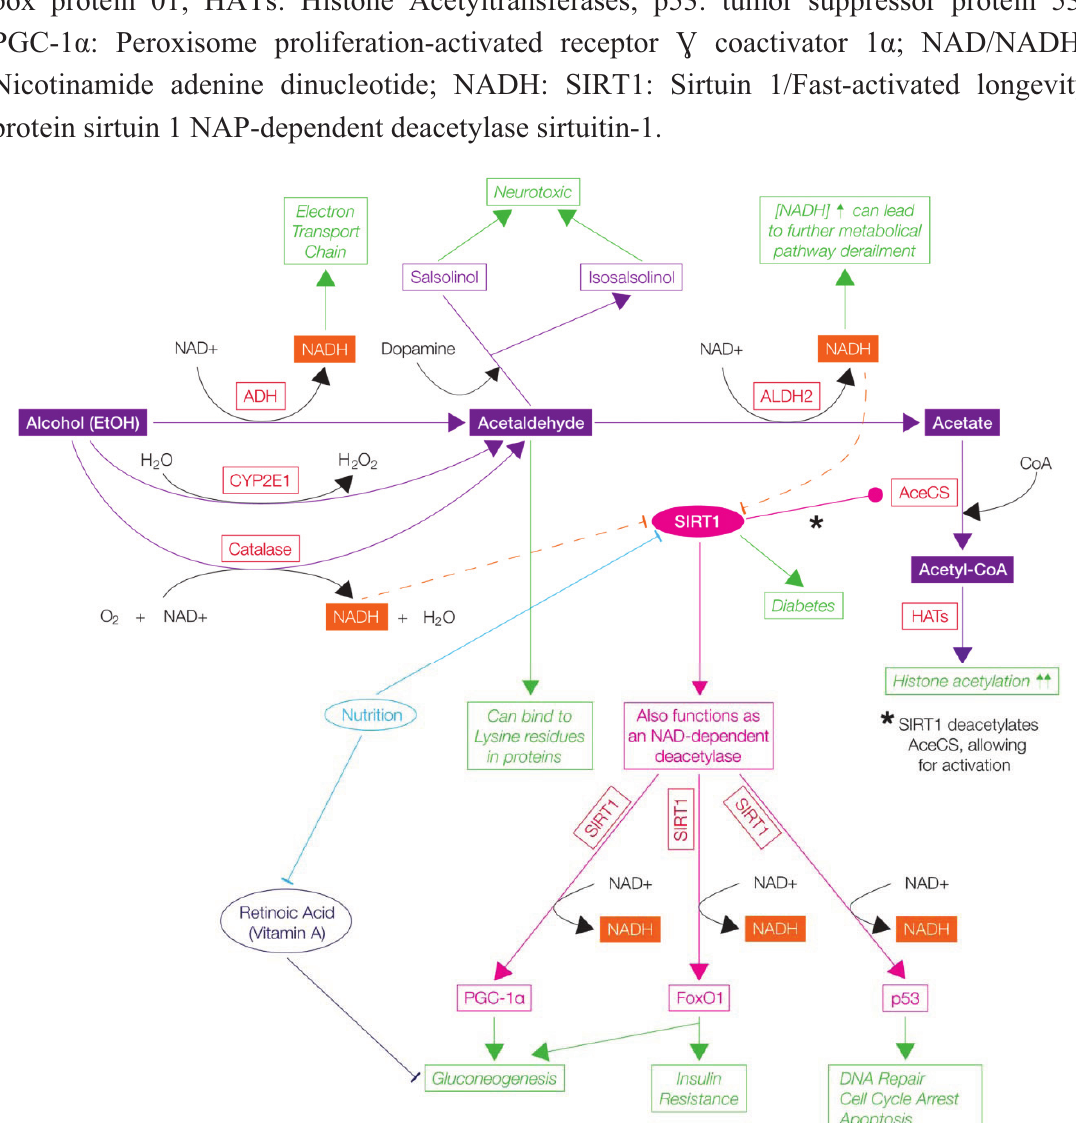
Figure 6. Alcohol (EtOH) metabolism and the effects its metabolites are exhibited in various metabolic and cellular processes. Various ethnic groups and populations have copy number differences and polymorphisms in the ADH gene, which in turn have an effect on how they metabolize alcohol [218]. High concentrations of alcohol (ethanol) modifies neurotransmitters (e.g., gamma amino butyric acid (GABA) A , N -methyl-D-aspartate (NMDA), NMDA-receptor (NMDAR) subunits) [165,212], while acetaldehyde can bind lysine residues in proteins as well as dopamine which results in salsolinol and isosalsolinol [212]. Although at first a stimulant, at higher quantities ethanol is also a depressant. This indicates that ethanol and its metabolites are essentially neurotoxic, and overtime can lead to a variety of health problems, including poor nutrition, addiction, mood disorders, cirrhosis of the liver and cancer [212,218,219]. Green boxes and arrows demonstrate the resulting cellular functions.